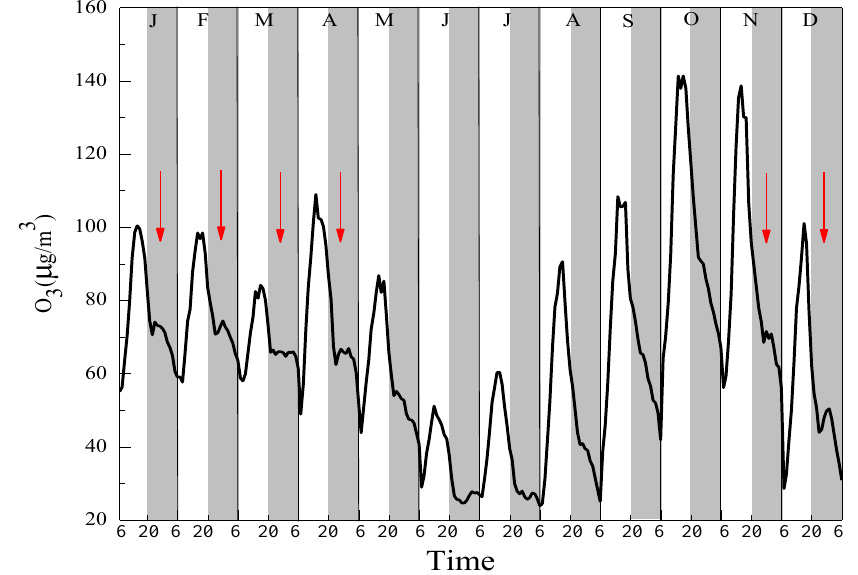
Figure 2. Daily variation in O 3 concentrations in individual months of 2020. Gray indicates nighttime.